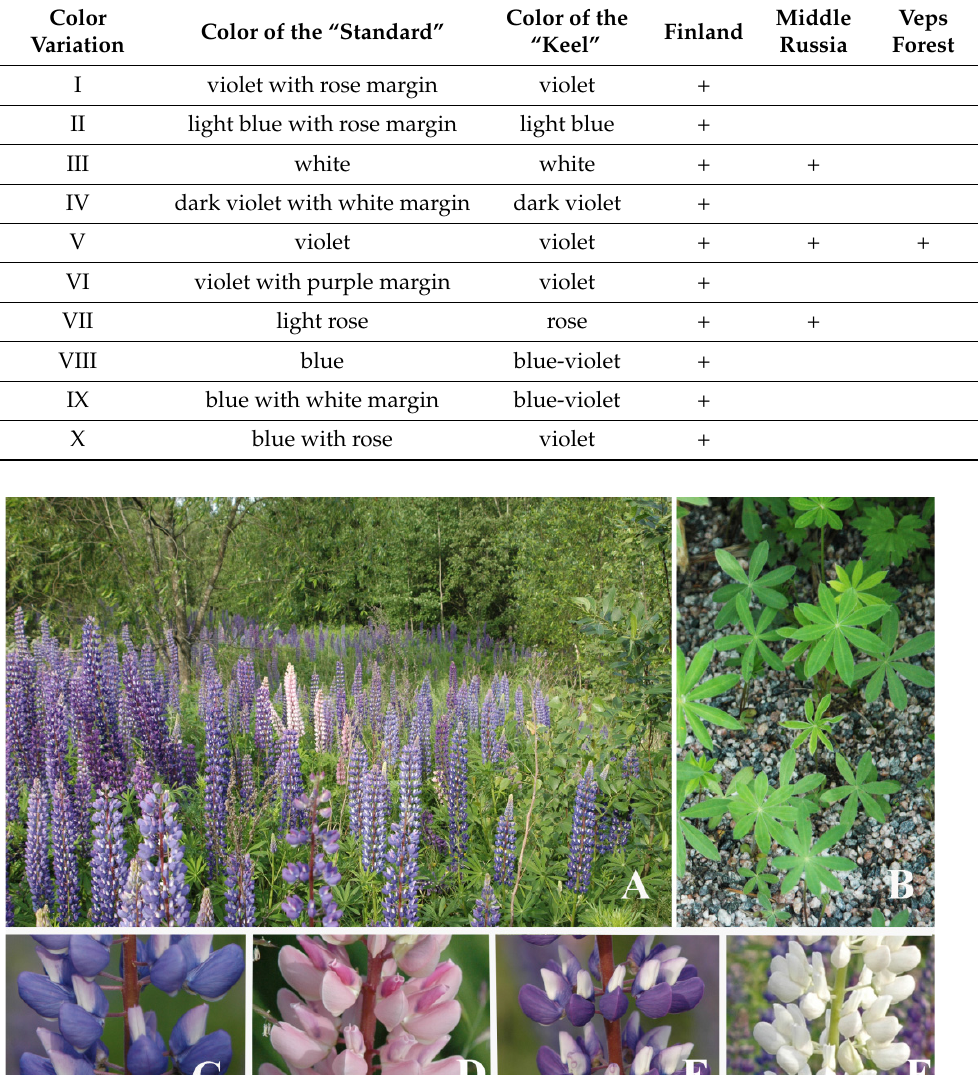
Table 3. Color variability of the flower of Lupinus polyphyllus from invasive populations.